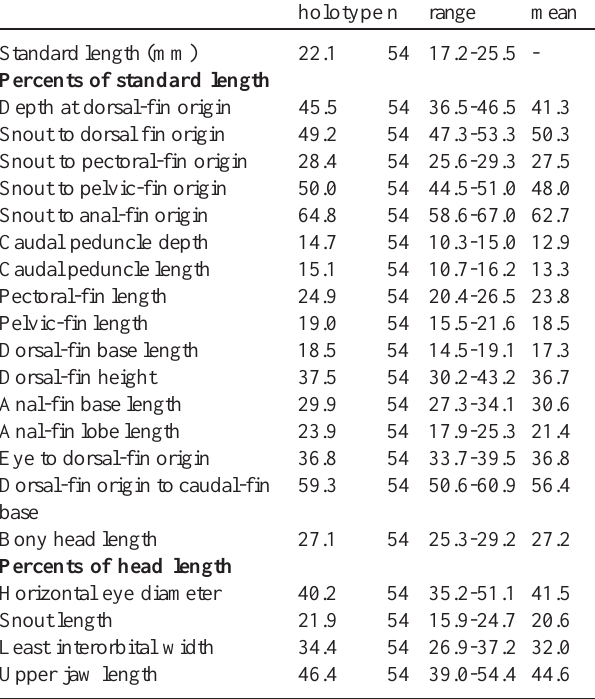
peduncle, grayish pale, with bluish, bright silvery coloration. Deep gray stripe present on anal-fin base. Dorsal and ventral midlines bright orange. Orange pigmentation present on basal portion of dorsal and caudal fin, distal portion of anal-fin lobe, and pelvic fin. Black stripe extends along middle caudal- fin